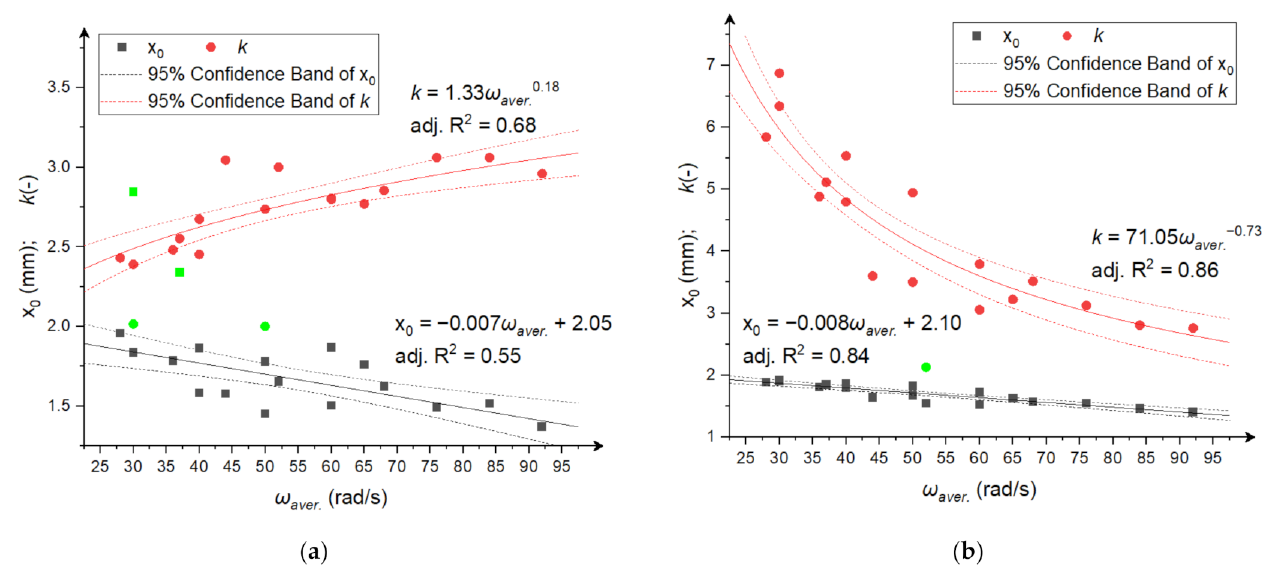
Figure 6. The dependence between RRSB distribution parameters and average angular disc velocities during comminution; ( a ) corn grains; ( b ) rice grains. The green points are outliers not included in the